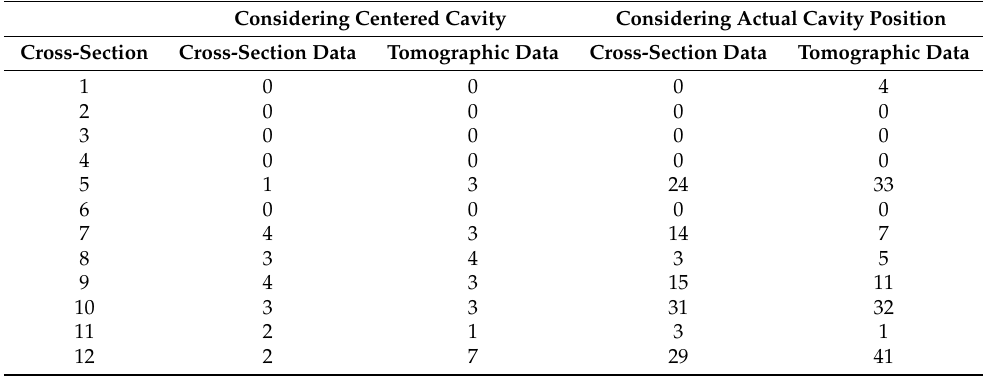
Table 4. Differences (in percentage) of the second moment of area considering the cavity (if any) centered or eccentric.